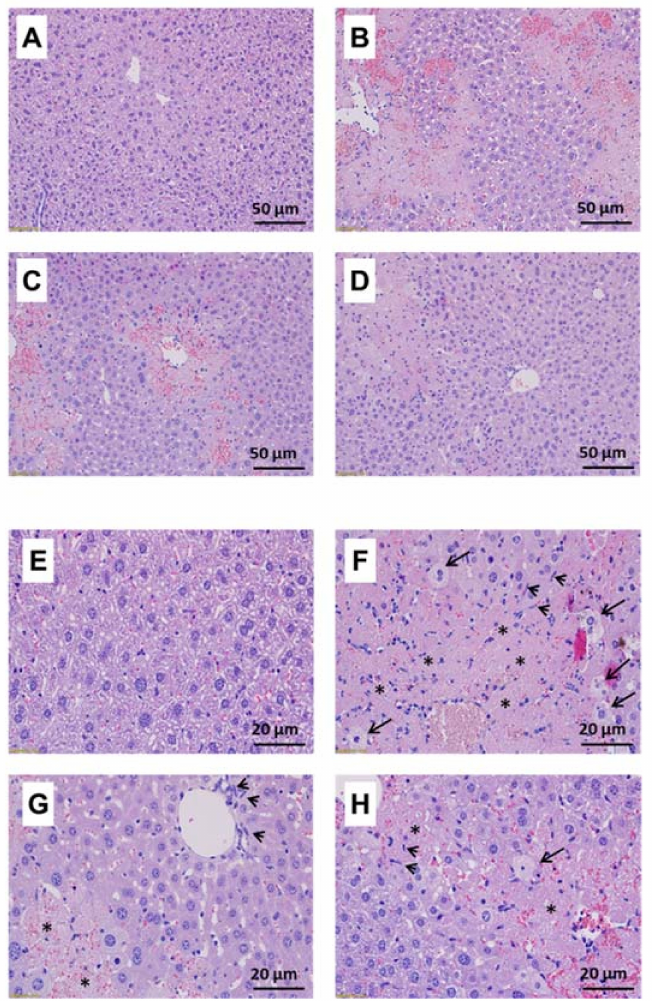
Figure 5. Effect of BLE on liver histology in CCl 4 -treated BALB/c mice. ( A , E ) Normal; ( B , F ) CCl 4 ; ( C , G ) BLE100; ( D , H ) BLE400. Histologic sections were made from liver tissues and stained with hematoxylin and eosin. Representative images were collected at high magnification (( A – D ) × 200; ( E – H ) × 400). The long arrow and the asterisk indicate hepatic injury (ballooning degeneration) and necrosis, respectively, and the short arrow indicates inflammatory cell